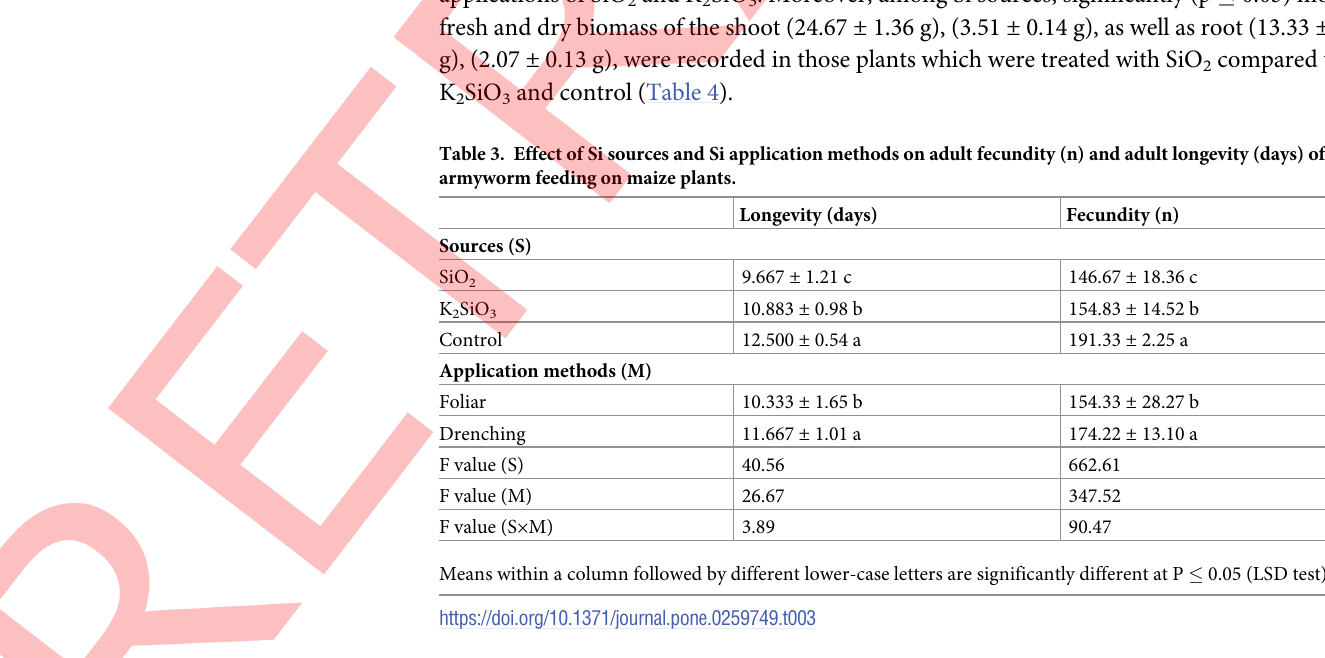
Table 3. Effect of Si sources and Si application methods on adult fecundity (n) and adult longevity (days) of fall armyworm feeding on maize